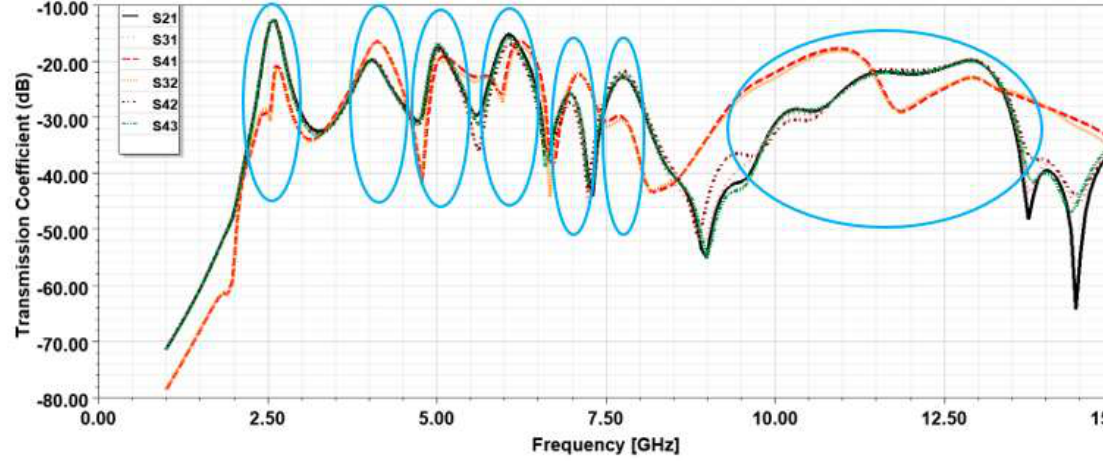
Figure 12. The transmission coefficients between all four ports.